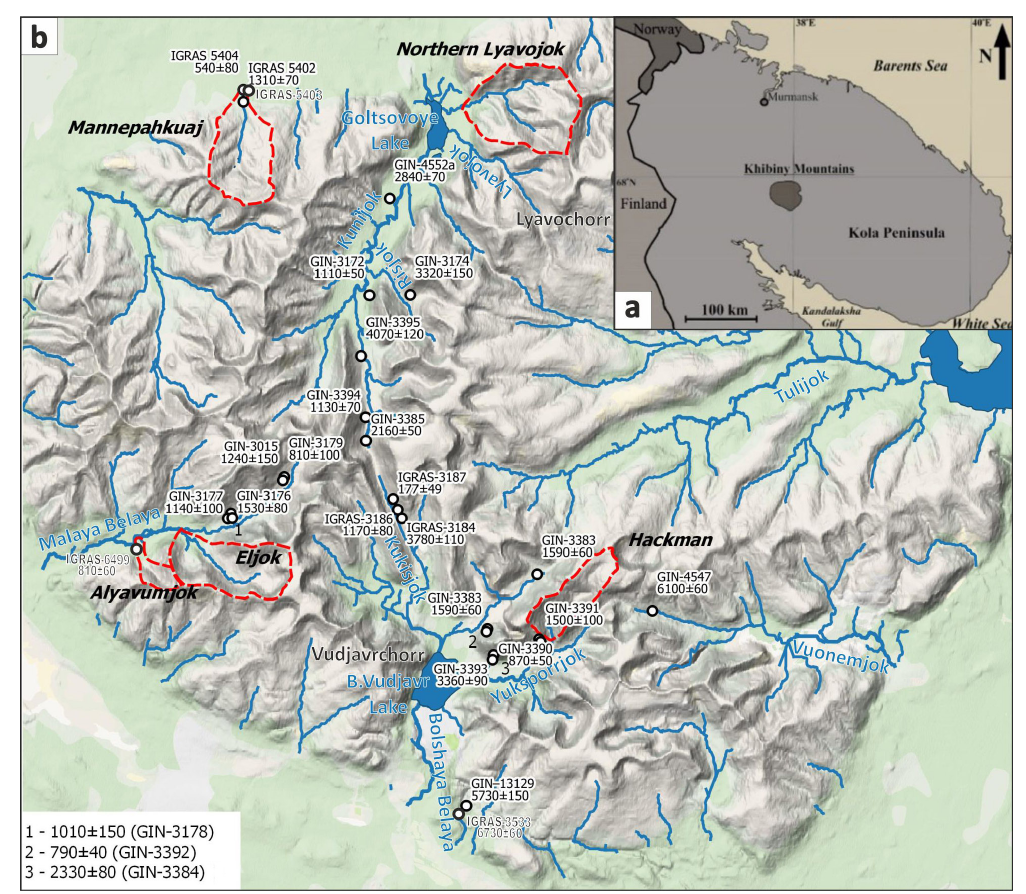
Figure 1. Location of the Khibiny Mountains on the Kola Peninsula, NW Russia (a) and case study basins (b) (source: © Google global topography, infrastructure and settlements). Panel (b) shows the distribution of a dataset of 14 C dates of buried organic-rich horizons in colluvial and debris flow fans (after Sulerzhitskiy et al., 1986; Vashchalova, 1987; Bozhinsky and Myagkov, 2001; Vladychensky et al., 2007; Kosareva, 2007; Romanenko et al., 2011, with